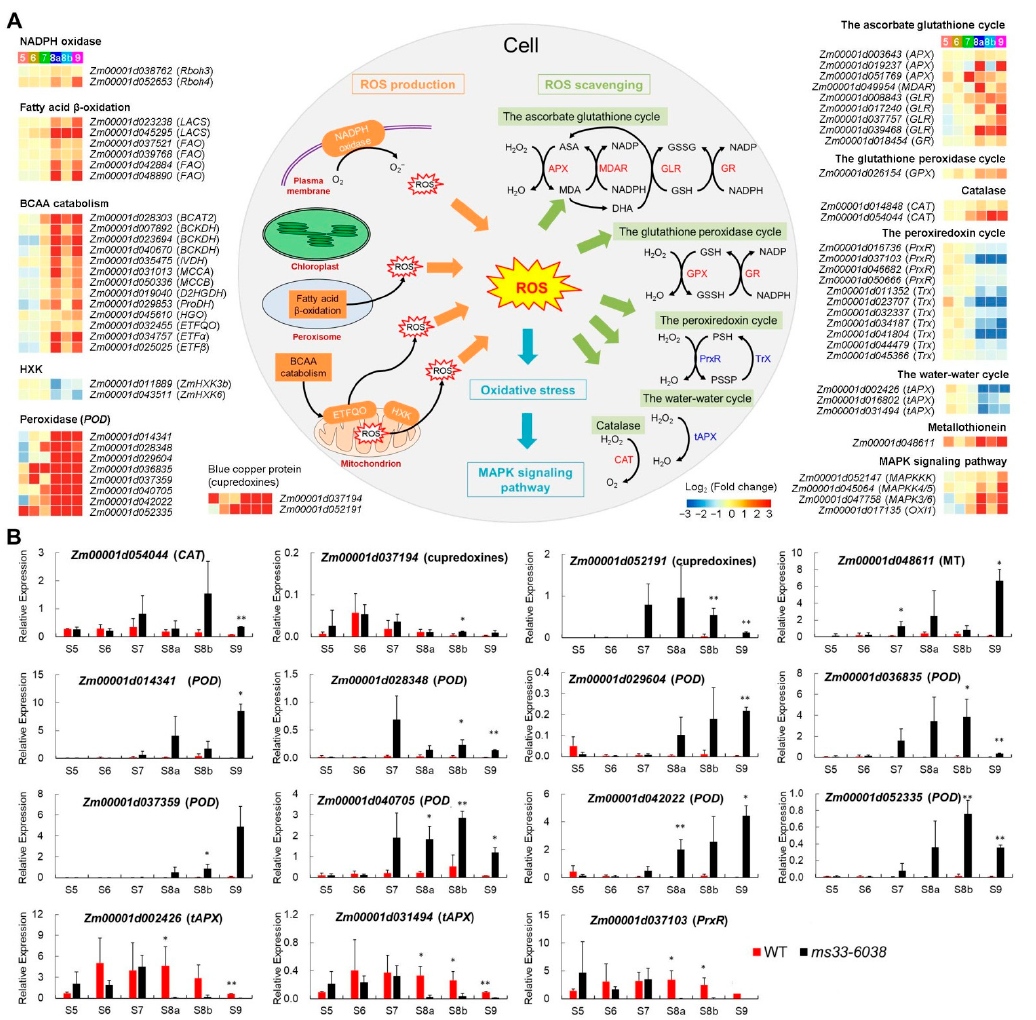
Figure 5. Transcriptional changes of genes related to ROS metabolism and oxidative stress responses in ms33-6038 anthers. ( A ) Expression changes of 64 genes involved in ROS production, ROS scavenging, and oxidative stress responses. ( B ) Validation of expression change patterns of 15 representative genes related to ROS metabolism and oxidative stress response by qPCR analysis. * p < 0.05, ** p < 0.01, Student’s t -test.